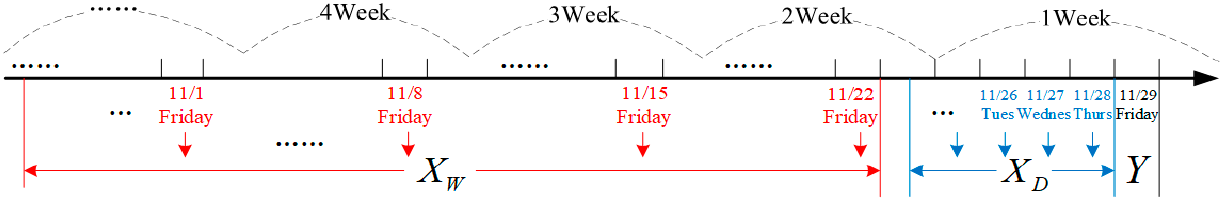
Figure 7. An example structure for the MT.